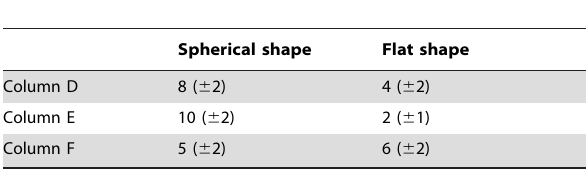
Table 2. The average number of dengue viruses that were observed and counted separately as spherical viruses and flat viruses on the SEM